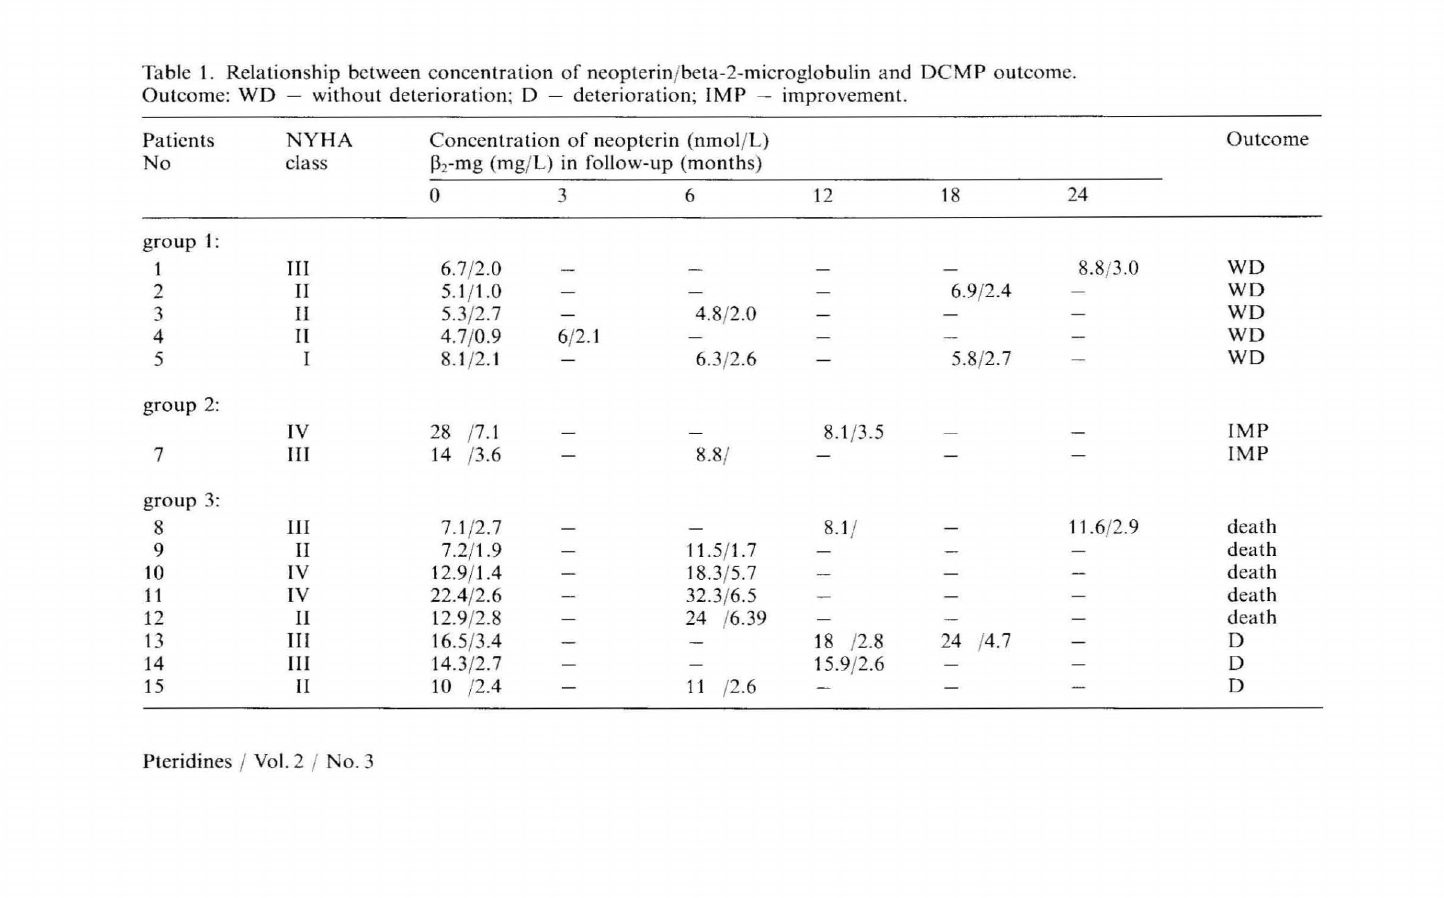
Table I. Relationship between concentration of neopterin/beta-2-microglobulin and DCMP outcome. Outcome: WD - without deterioration; D - deterioration; IMP - improvement.